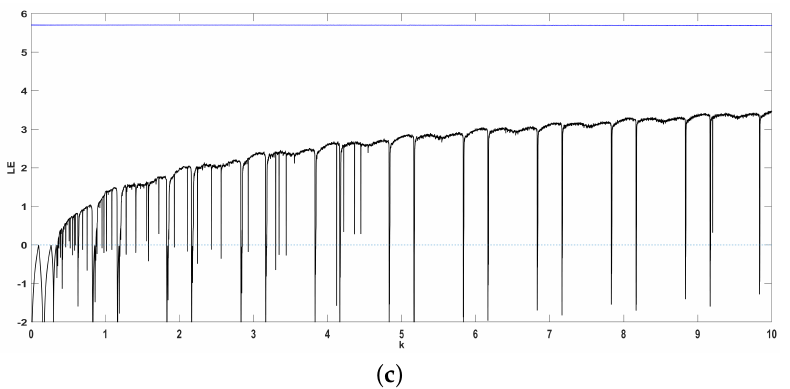
Figure 10. Bifurcation diagrams for ( a ) the sine–sine map (26) and ( b ) the modified sine–sine map (27) with respect to parameter k , for a = 300, N = 1. ( c ) LE of the sine–sine map (26) (black) and modified sine–sine map (27) (blue).